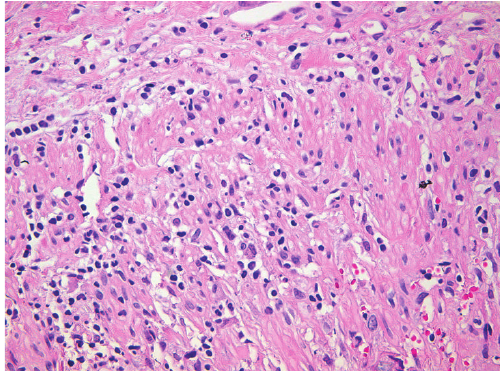
Figure 1: Destruction of the wall by an inflammatory infiltrate containing multinucleated giant cells associated with the internal elastic lamina of the artery (Hematoxylin-Eosin ×